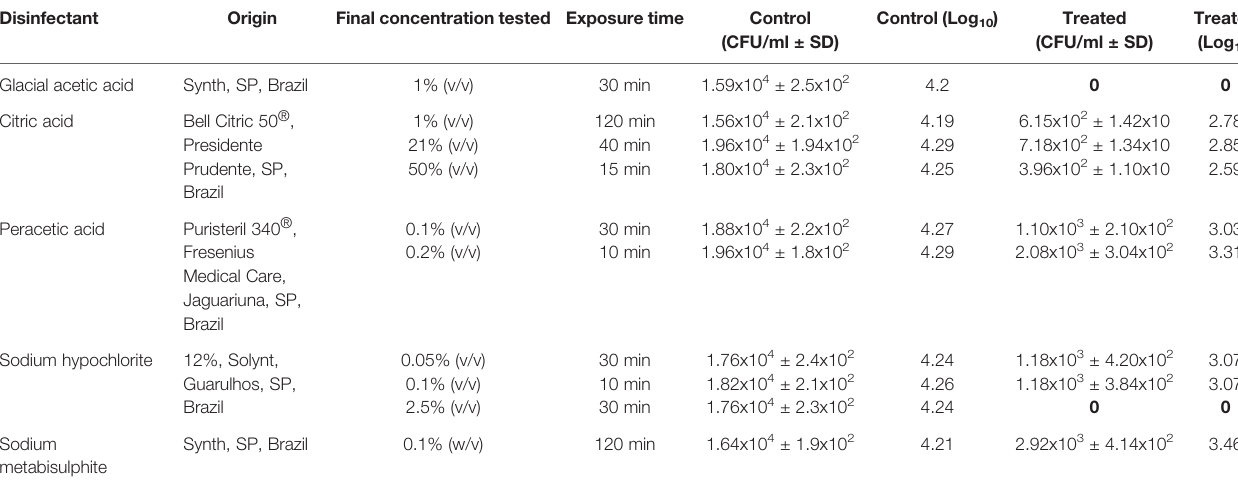
TABLE 4 | Disinfectants activities against Aspergillus plactonic